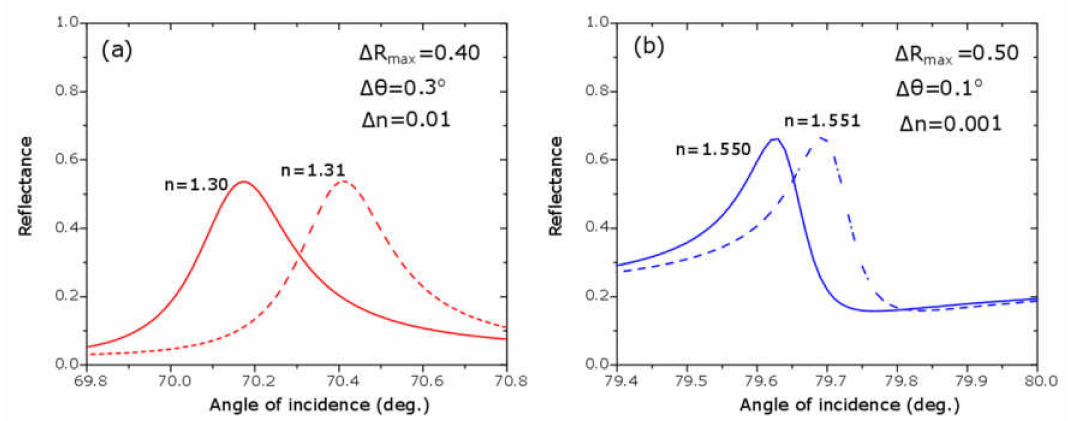
Figure 8. Fitted ATR spectrum 6c (t H = 139 nm) near Fano resonances for samples with refractive index ( a ) near water and ( b ) near egg white, which allows one to estimate the angular sensitivity and the figure of merit for this sensor. For water: S θ = 30 deg RIU − 1 and FOM = 40 RIU − 1 . For dried egg white: S θ = 100 deg RIU − 1 and FOM = 500 RIU − 1